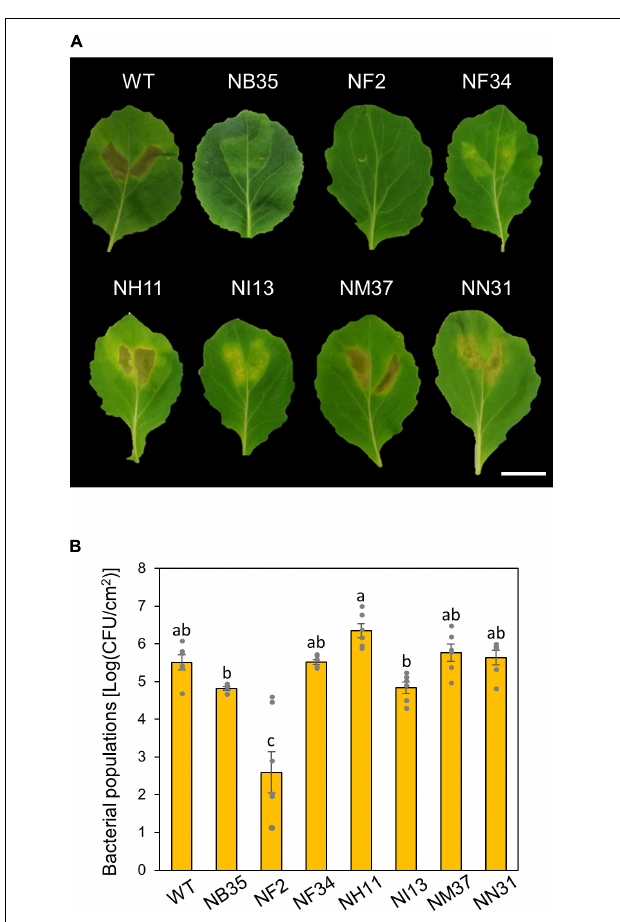
FIGURE 1 | Disease phenotypes and bacterial populations of Pseudomonas cannabina pv. alisalnesis KB211 WT and amino acid mutants in cabbage after syringe-inoculation. Disease symptoms (A) and bacterial populations (B) on cabbage leaves syringe-inoculated with WT, a type three secretion system (T3SS) mutant (NB35) and six amino acid metabolism mutants (NF2, NF34, NH11, NI13, NM37, and NN31) described in Supplementary Table 1 . Cabbage plants were syringe-inoculated with 5 × 10 5 CFU/ml of inoculum. The bacterial concentrations in the plant leaves were evaluated at 5 dpi. The leaves were photographed at 5 dpi. Scale bar shows 2 cm. Vertical bars indicate the standard error for at least six independent experiments. Different letters indicate a significant difference among treatments based on a Tukey’s HSD test ( p <